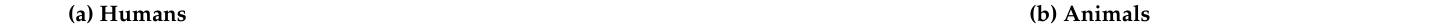
Table 9. Comparing the effects of changes to the expression of homologous genes (a) on hypertension development in humans and (b) during the divergence of domestic and wild animals from their most recent common ancestors.